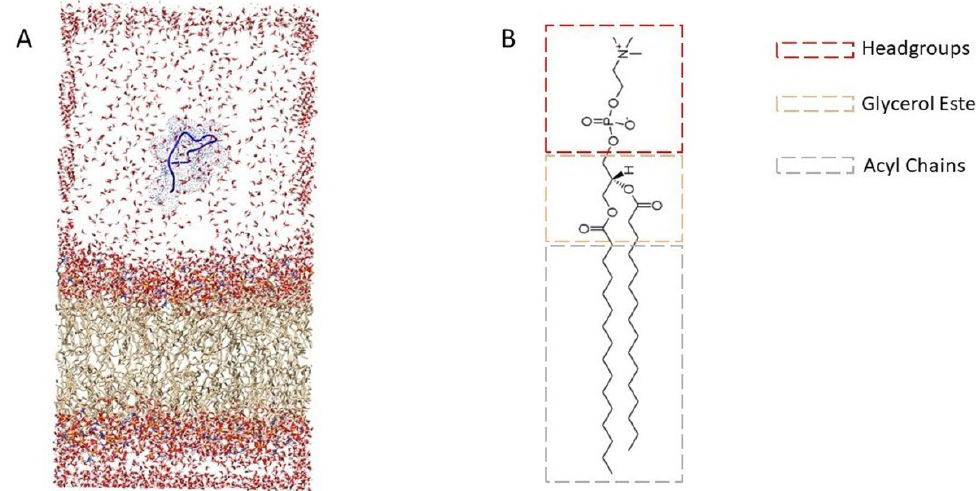
Figure 2. ( A ) Snapshot of the initial configuration of the DPPC membrane in the presence of the AHB-2 peptide, which was in the water at 5 nm from the COM of the membrane. ( B ) Chemical structure of dipalmitoylphosphatidylcholine (DPPC) with its main components indicated by dotted boxes.